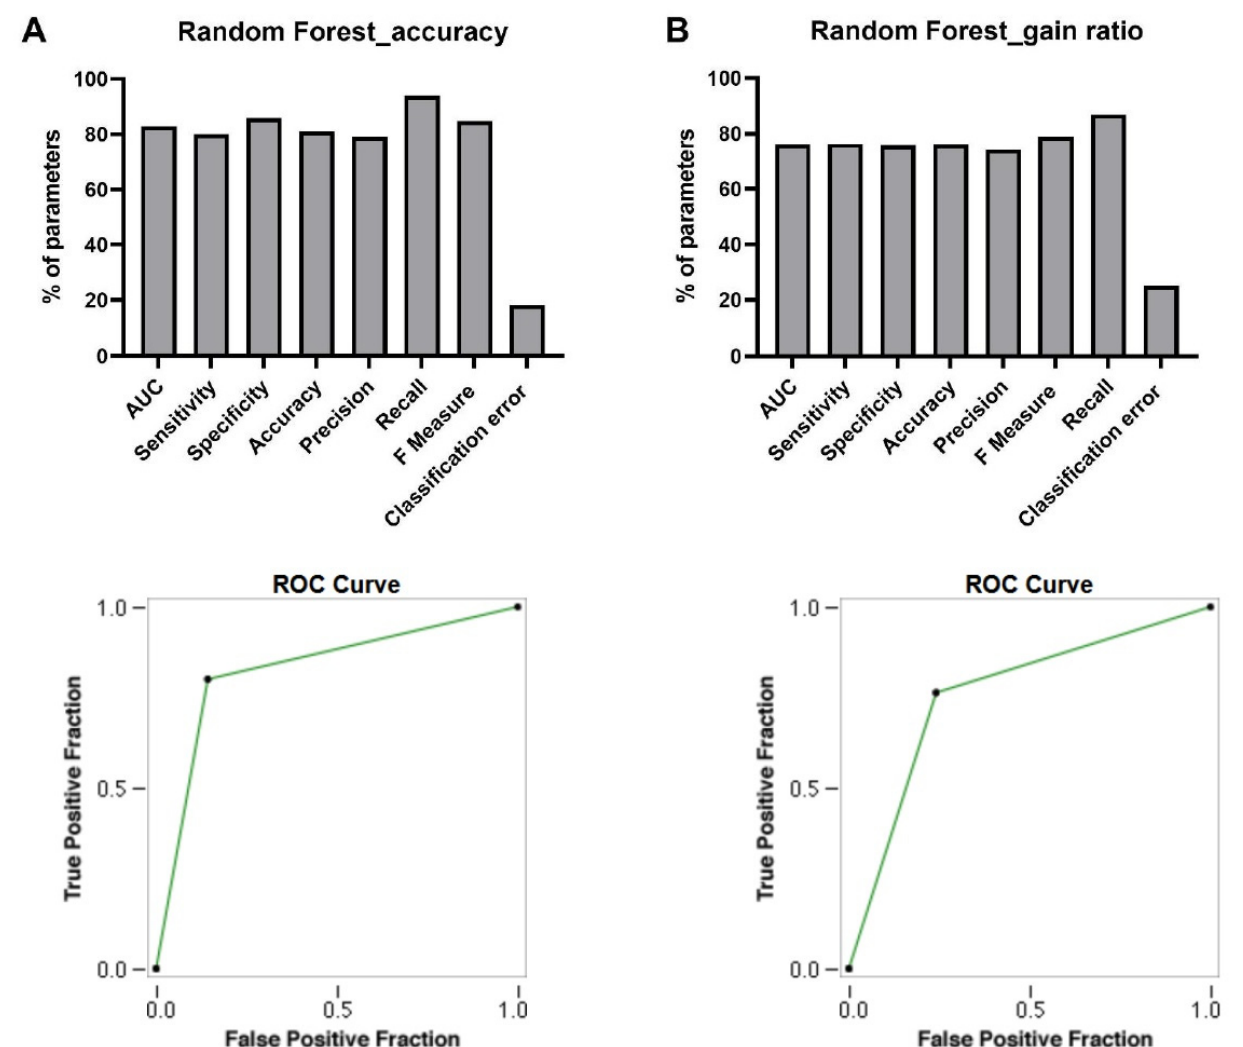
Figure 4. Comparison the performance of Random Forest accuracy ( A ) with Random Forest gain ratio ( B ).